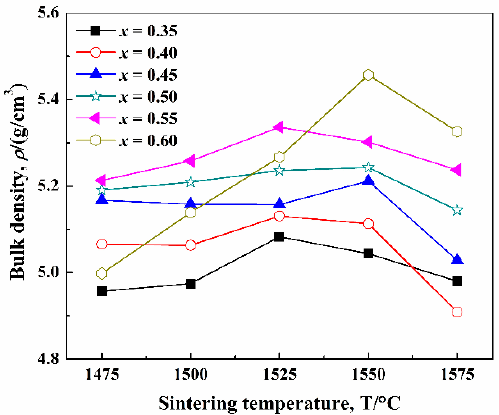
Figure 1. Bulk density of the (1– x )CLT- x NMT ceramics.